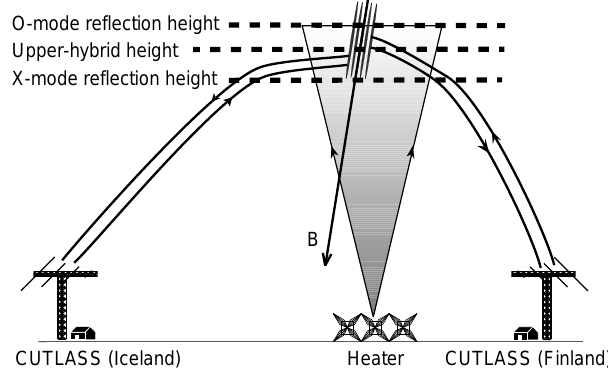
Fig. 1. A schematic illustrating the relative beam geometry of the EISCAT heater and the CUTLASS radars